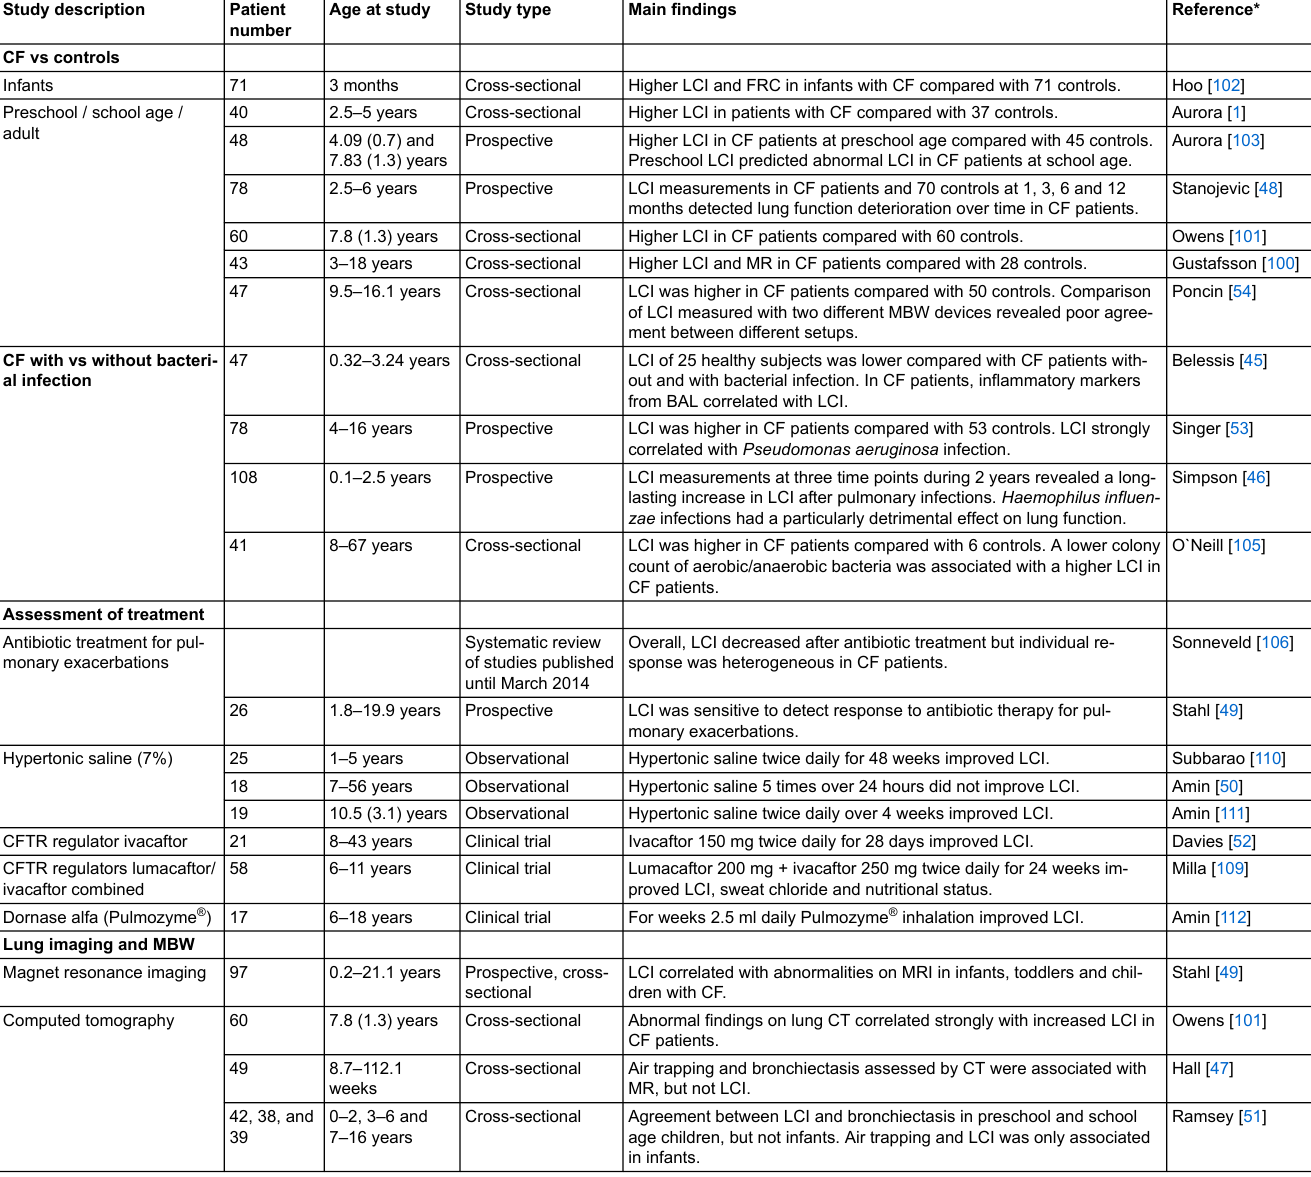
Table 2: Overview of studies in paediatric patients with cystic fibrosis using multiple-breath washout measurements. Study